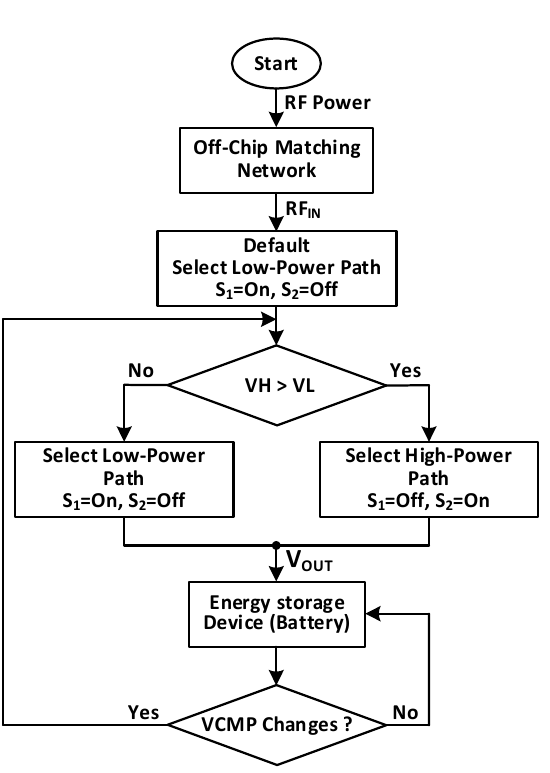
Figure 5. Flowchart of the proposed reconfigurable RF-DC converter.